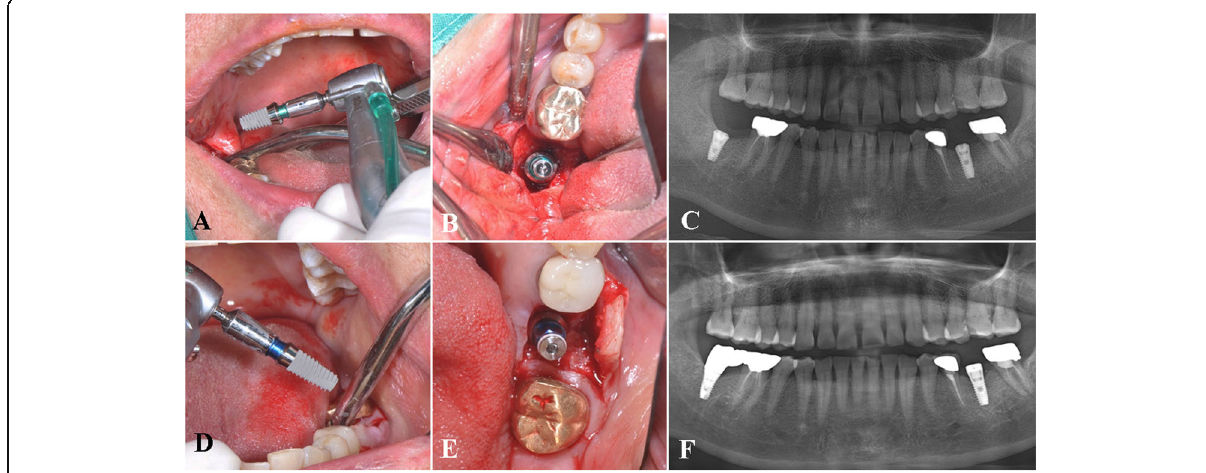
Fig. 5 A representative case of bilateral implants placed in the posterior mandible. Intraoperative view of a 4.5 mm in diameter and 7 mm in length implant placed in the #47 area ( a – b ), postoperative panoramic view ( c ), placement of a 4.0 mm in diameter, 8.5 mm in length implant in the #36 area ( d – e ), and postoperative panoramic view ( f )